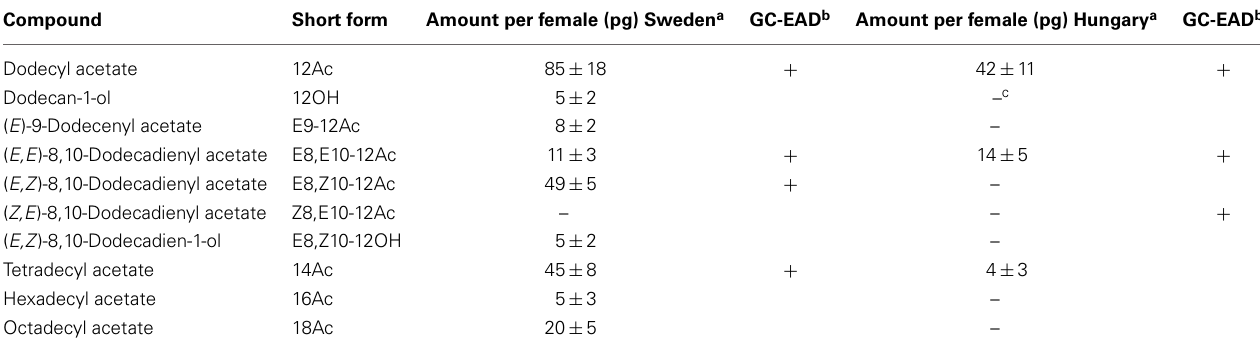
Table 1 | Compounds identified from pheromone gland extracts of C. splendana females from oak Q. robur (Sweden) and chestnut C. sativa (Hungary), by GC-MS and